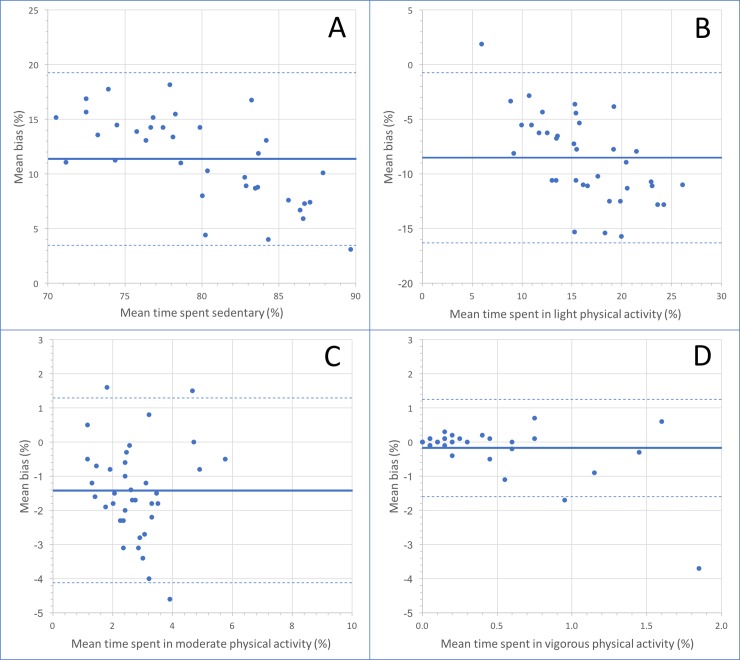
Bland-Altman plots comparing ActiGraph (normal filter) and Actical estimates of time spent in (A) sedentary, (B) light, (C) moderate, and (D) vigorous physical activity.